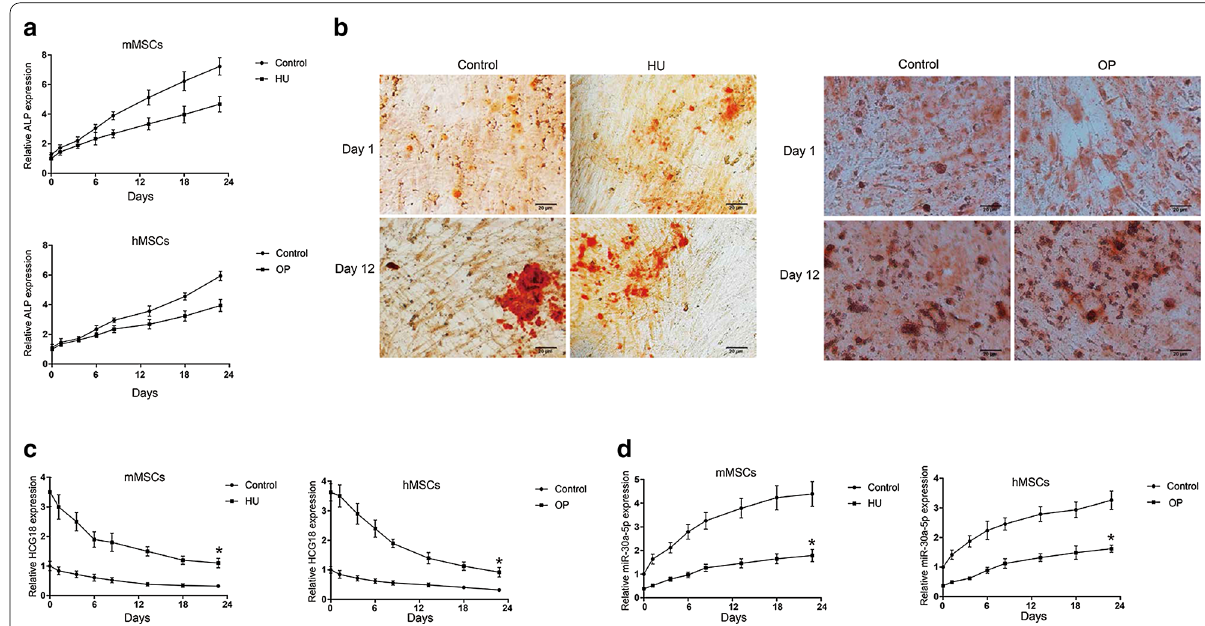
Fig. 2 Expression of HCG18 and miR-30a-5p in BMSCs of HU mice and OP patients. Expression of a ALP, c HCG18 and d miR-30a-5p were detected in BMSCs during 23 days’ induction. b Presentative figures of ALP staining. ALP staining was performed at days 1 and 12, respectively (magnification, 100). White arrows indicate areas of ALP activity. Bars represent standard deviation from 6 independent biological replicas of the ×